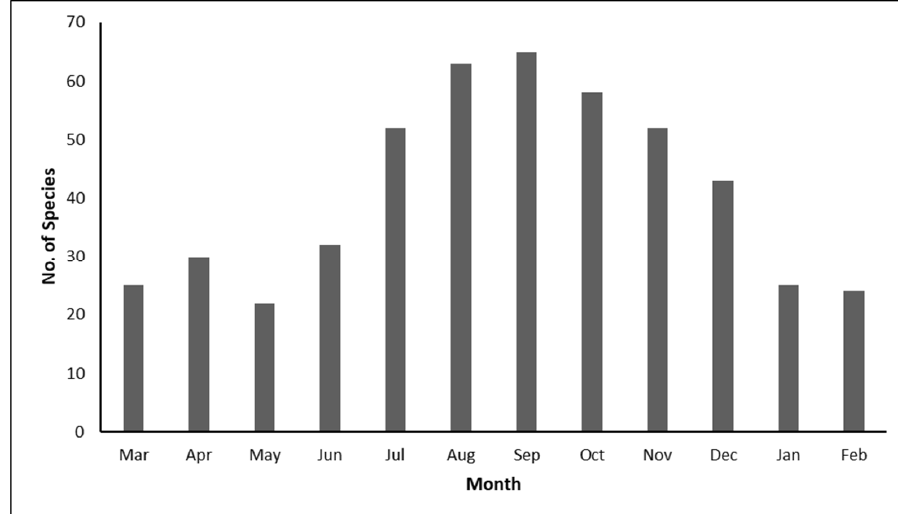
Figure 4. Month-wise composition of butterfly species in the study area